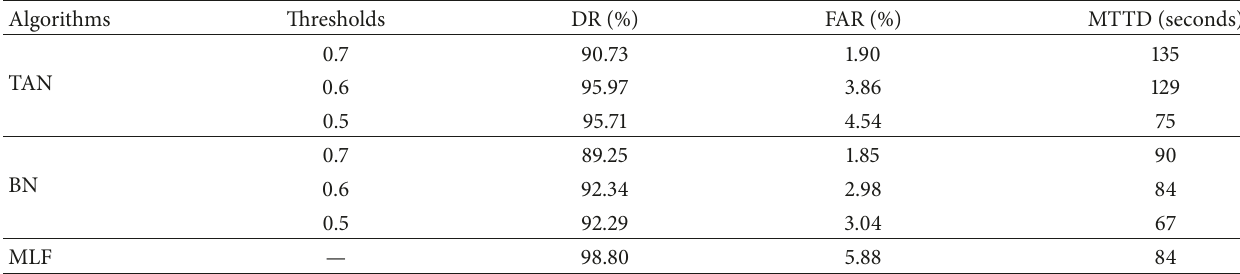
Table 4: Comparison between TAN and MLF with AYE data.